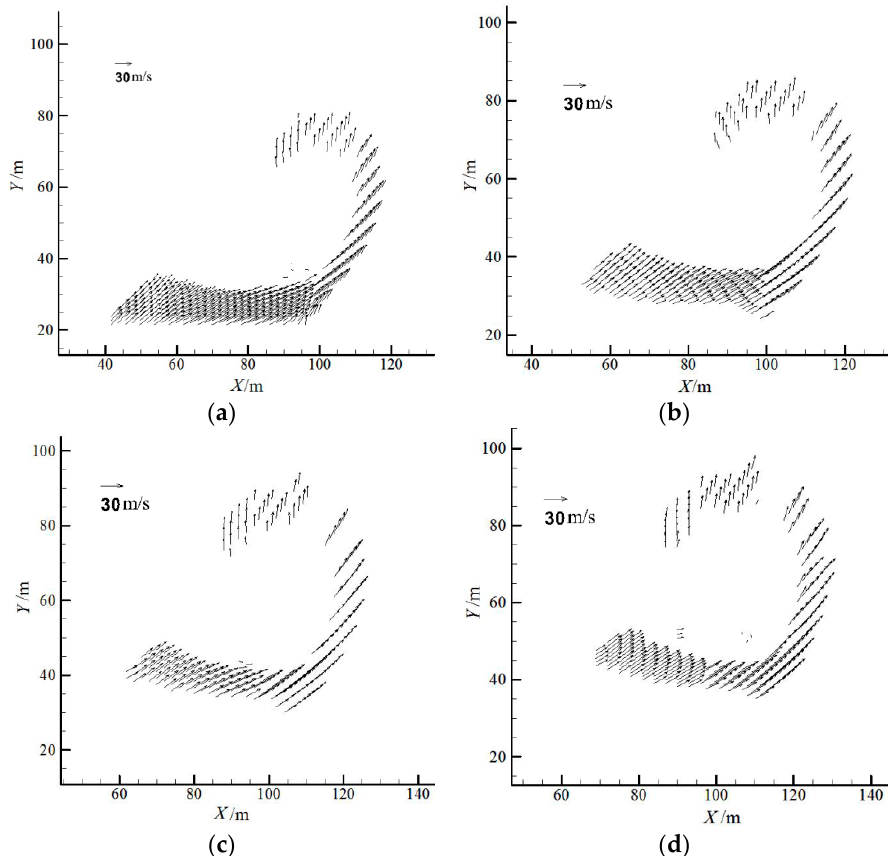
Figure 6. Velocity vector distributions of free jet flow: ( a ) Z = − 17 m; ( b ) Z = − 22 m; ( c ) Z = − 27 m; ( d ) Z = − 32 m.